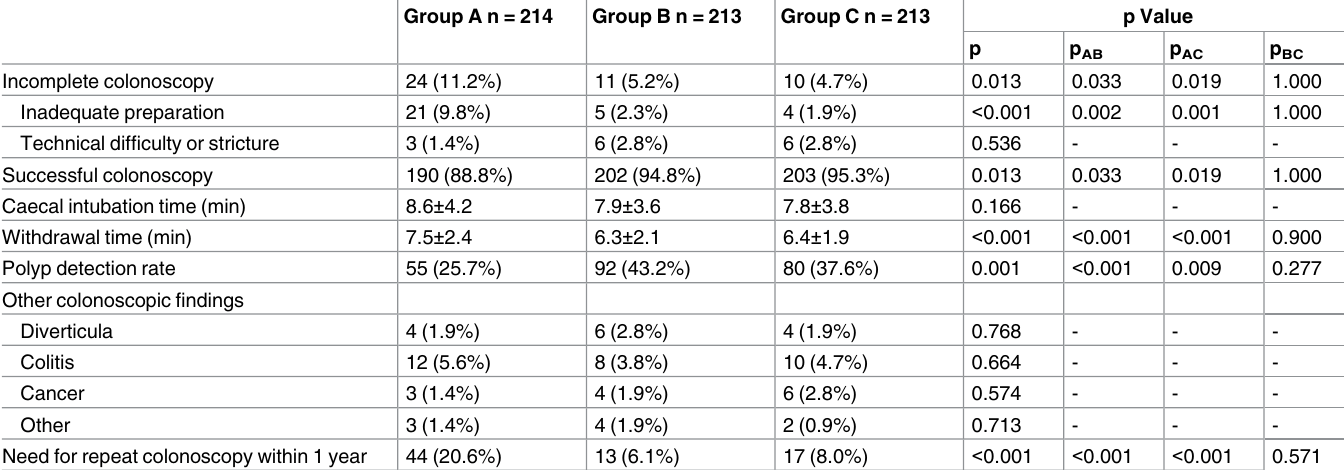
Table 3. Outcomes of colonoscopy in 3